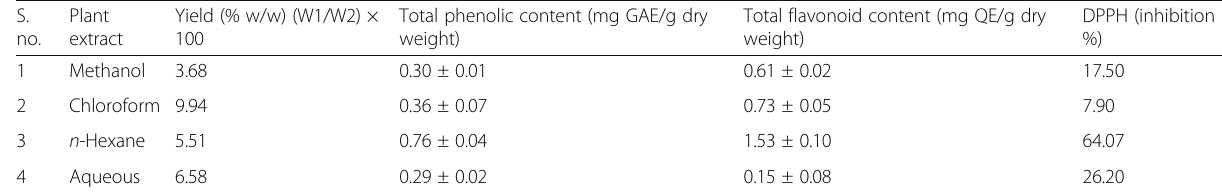
Table 1 Total phenolic content, total flavonoid content, and DPPH activity of fresh papaya flowers extracts S. no.